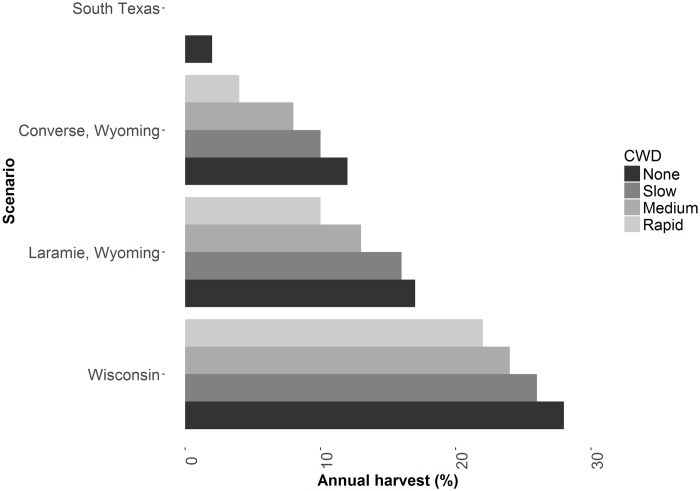
Maximum annual harvest of adult male and female deer with slow, medium, and rapid CWD prevalence growth rates.CWD increased annually at rates of 0.26% (slow), 0.83% (medium) or 2.3% (rapid). Absent bars indicate scenarios when harvest of both sexes caused a population decline.